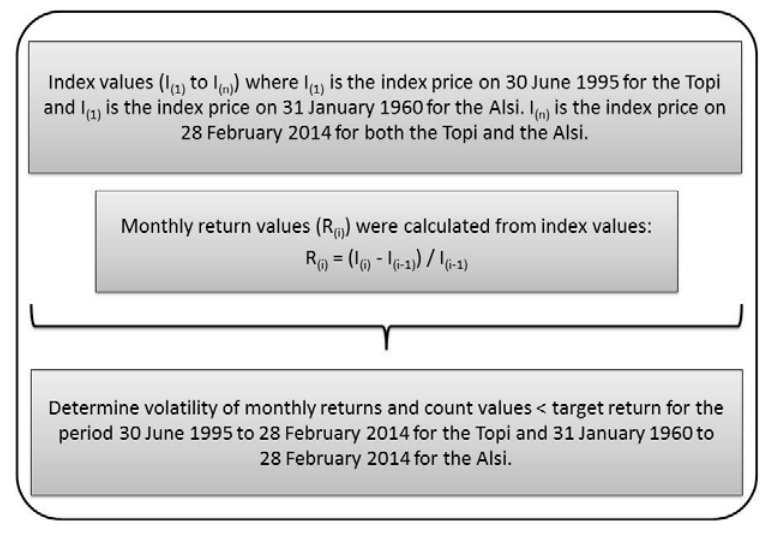
FIGURE 1: Determining the volatility of the Topi and the Alsi Source: Authors’